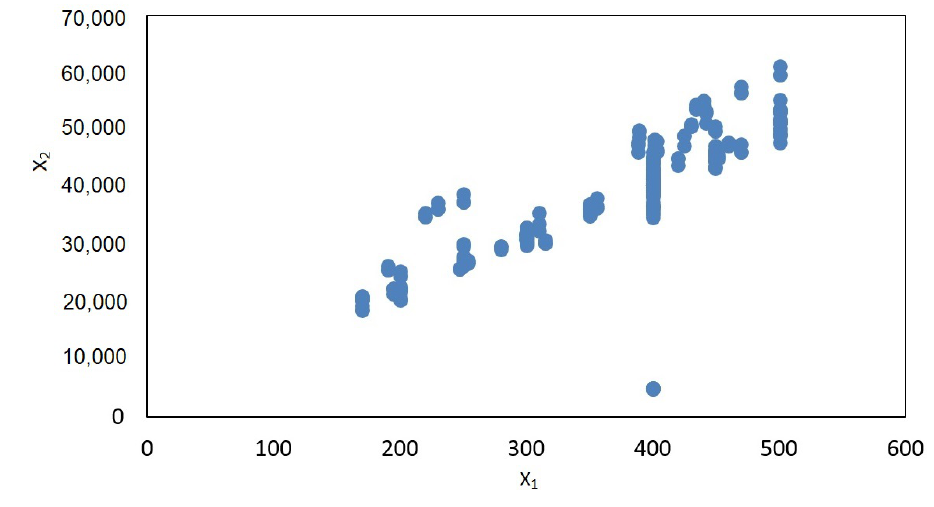
Figure 12. Scatterplot between indicators X 1 and X 2